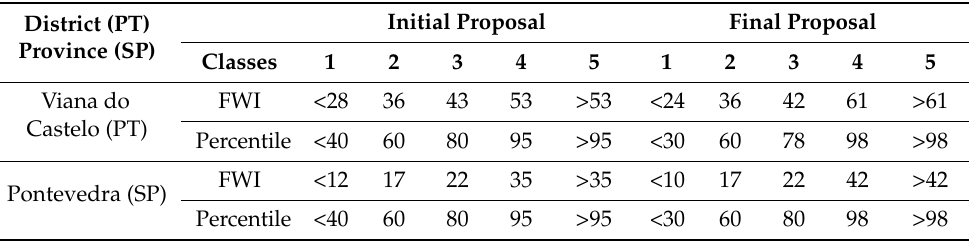
Table 4. FWI values and Percentile’s that limit the fire danger classes according to the initial and final proposal for the pair “Viana do Castelo—Pontevedra”. Classes names: 1—Low, 2—Moderate, 3—High, 4—Very high, and